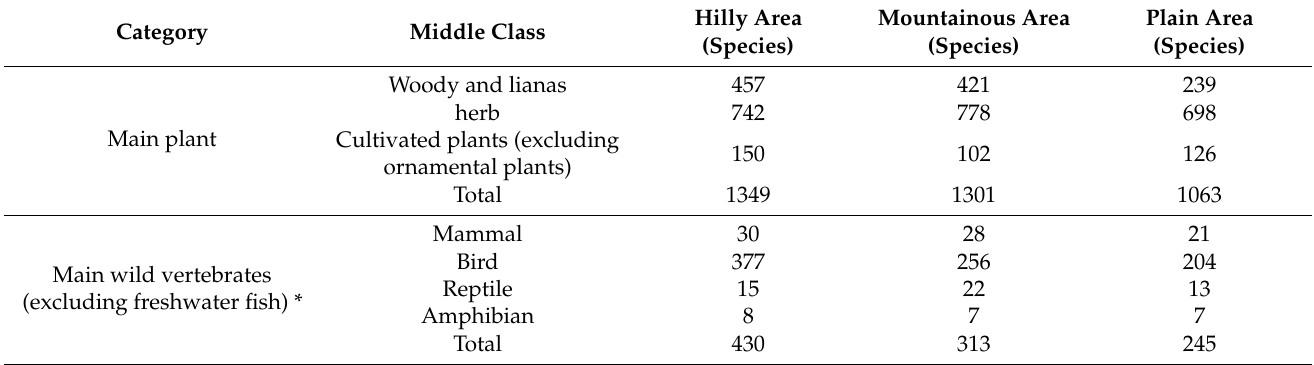
Table A1. Main animal and plant diversity data of the three topographic areas.